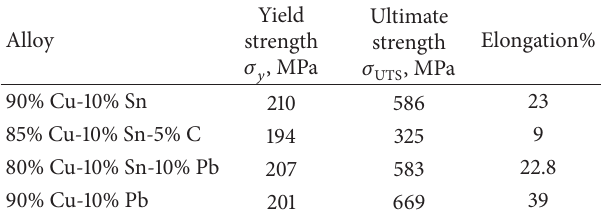
Table 3: The compressive test results for the Cu-based